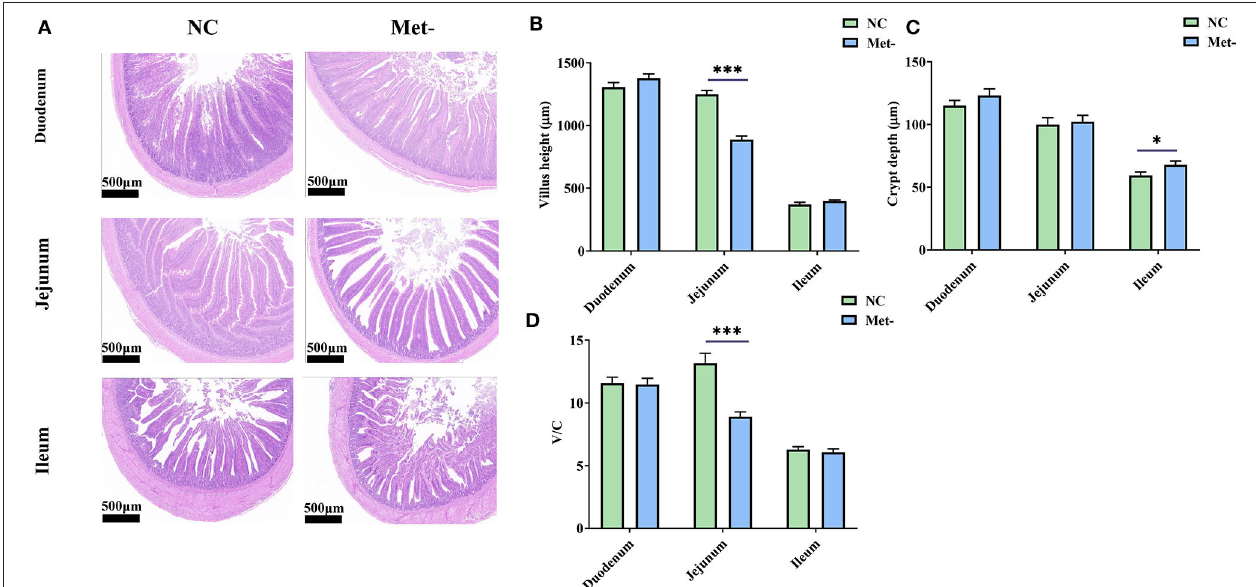
FIGURE 1 | Effects of Met deficiency in rearing period diets on small intestine morphologic structure of egg-laying chicks. (A) Representative samples from histological stained sections showed Met- group had lower jejunal villus height and deeper ileal crypt depth. (B) Villus height of duodenum, jejunum, and ileum. (C) Crypt depth of duodenum, jejunum, and ileum. (D) Villus height-to-crypt depth ratio (V/C) of duodenum, jejunum, and ileum. Data were presented as means ± SEM. Significant differences were tested by student’s t -test. *Indicates significant difference, P < 0.05; ***, P <